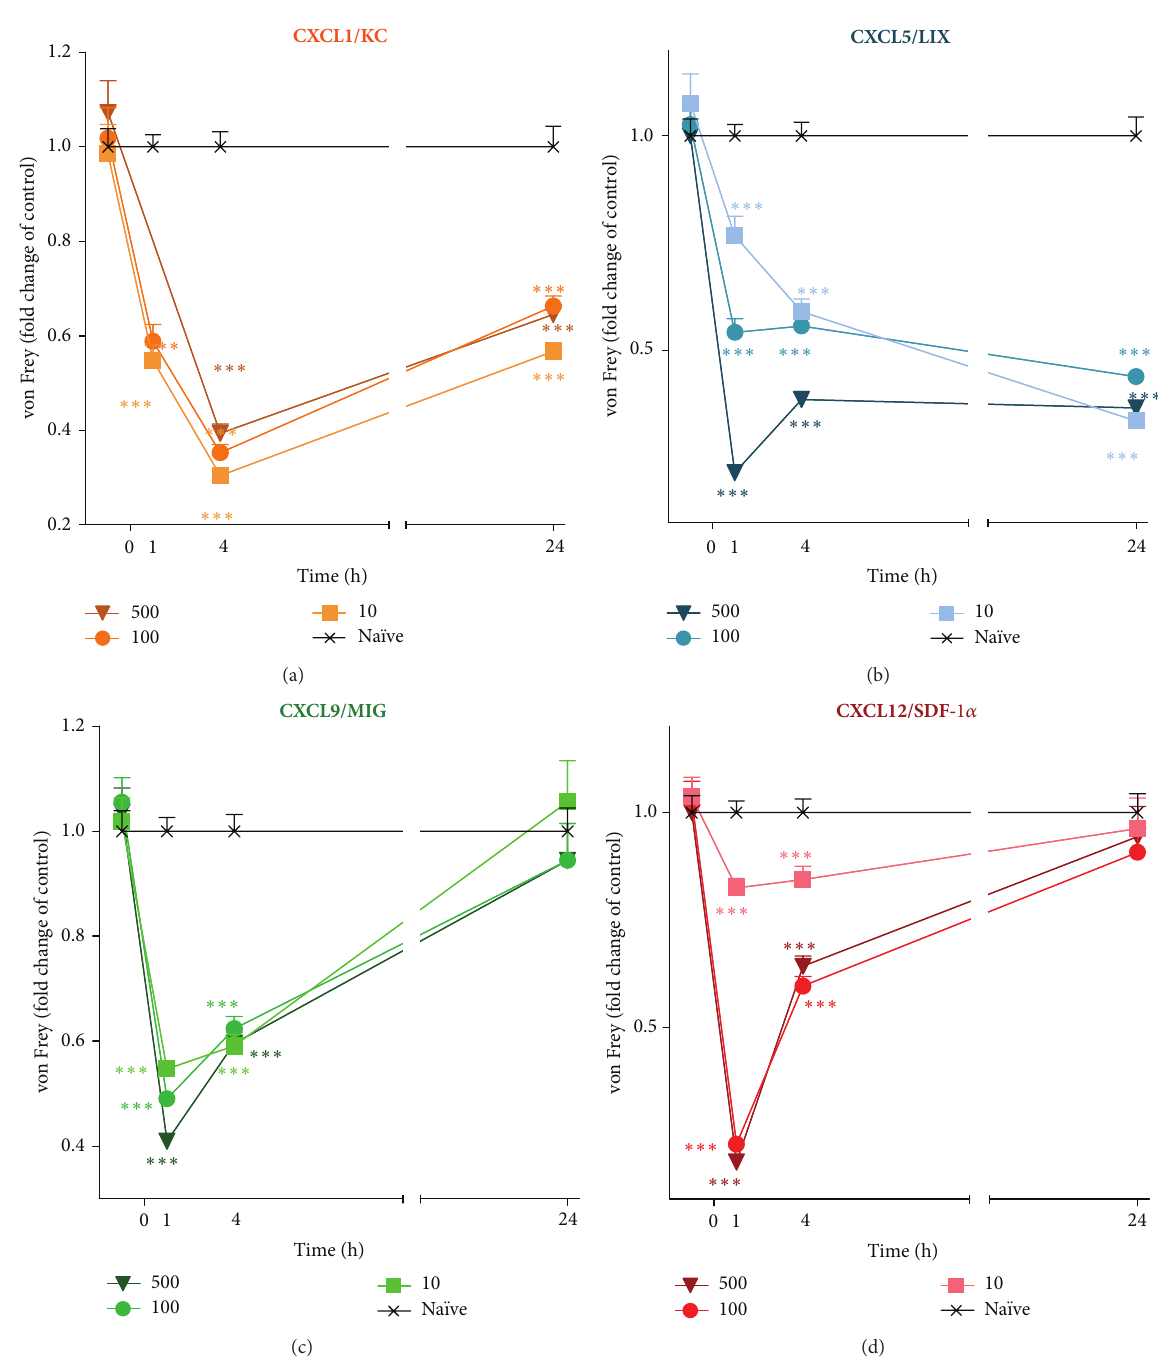
Figure 5: Effects of CXCL1, CXCL5, CXCL9, or CXCL12 administration on mechanical allodynia. The influence of a single intrathecal administration of 10ng, 100 ng, or 500 ng/5 𝜇 L of CXCL1 (a), CXCL5 (b), CXCL9 (c), or CXCL12 (d) on mechanical allodynia was evaluated using the von Frey test. The measurements were taken 1, 4, and 24 hours after chemokine administration. The data are presented as fold change in the control (na¨ıve) ± S.E.M. (6–16 mice per group). Intergroup differences were analyzed by an ANOVA and Bonferroni’s Multiple Comparison Test. ∗ 𝑃 < 0.05 , ∗∗ 𝑃 < 0.01 , and ∗∗∗ 𝑃 < 0.001 indicate a significant difference; the statistical analysis was performed versus control (na¨ıve)